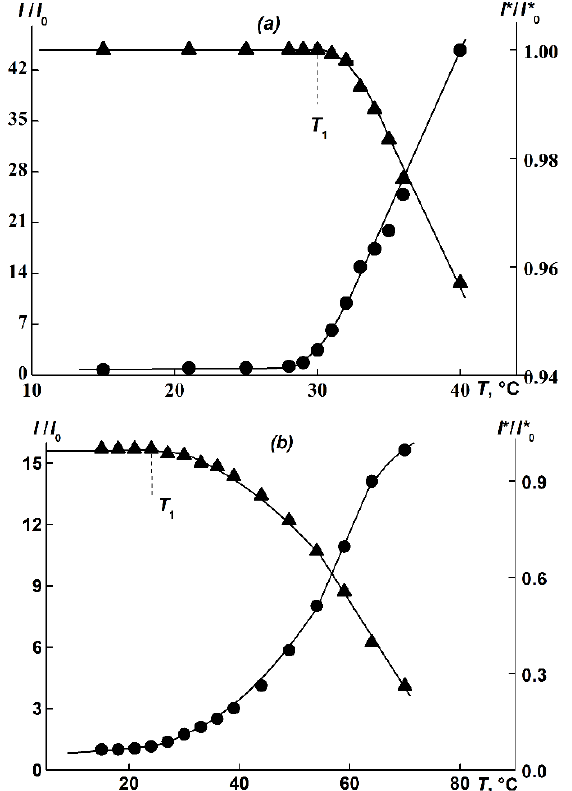
Figure 7. I/I 0 ( T ) and I */ I * 0 ( T ) for sample 1 ( a ) at c = 0.0022 g/cm 3 and sample 3 ( b ) at c = 0.016 g/cm 3 .